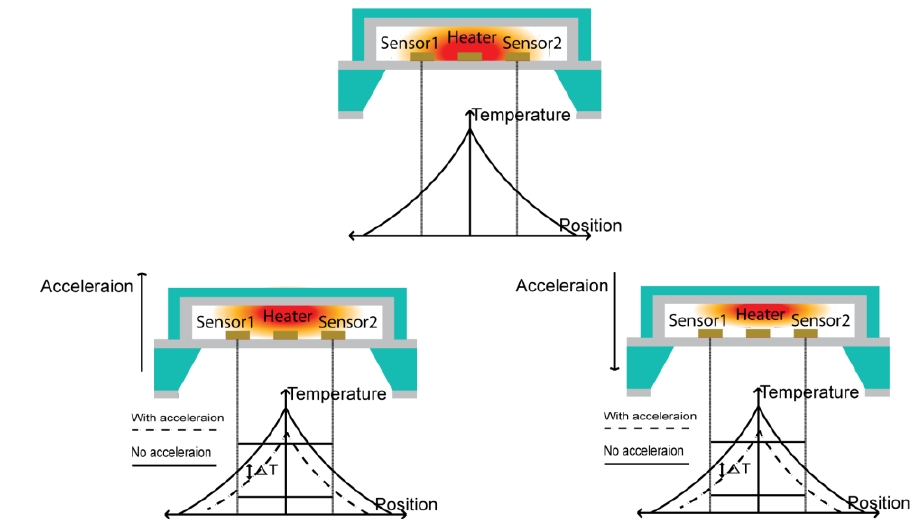
Figure 11. Schematic view of the Z-axis sensing principle.